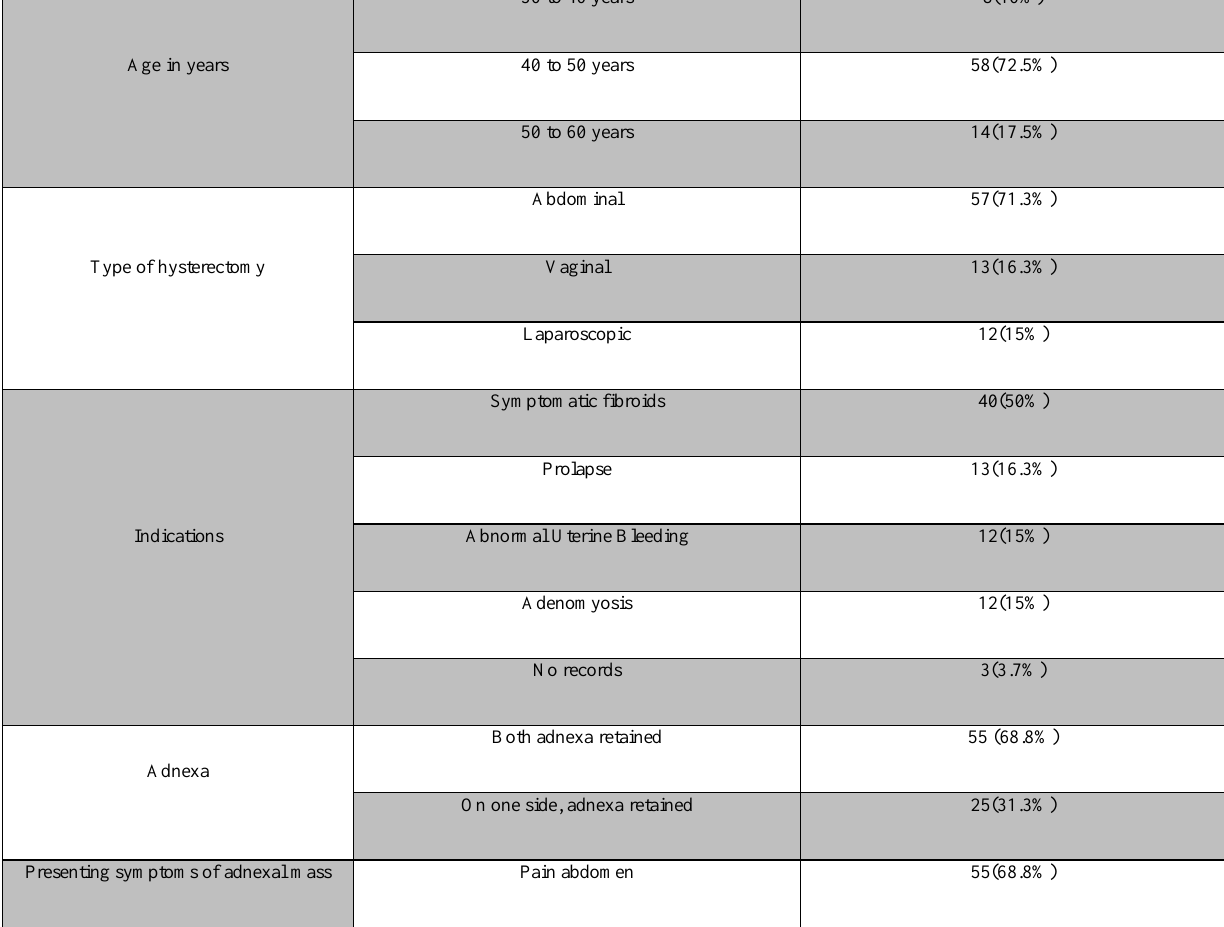
Table 1. Surgical details of hysterectomies and presenting symptoms of adnexal masses in 80 study subjects.